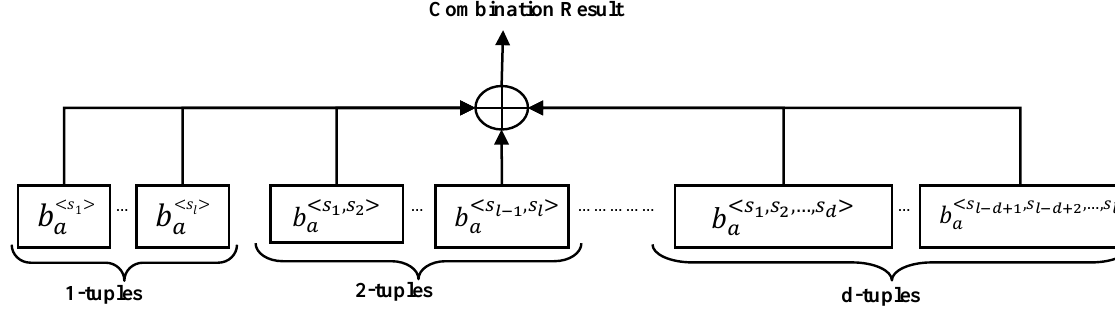
Figure 2. Belief mass combination for activity 𝒂 . Belief masses of triggered opinion-owners that belong to a’s frame of opinion-owners are combined using Dempster’s combination